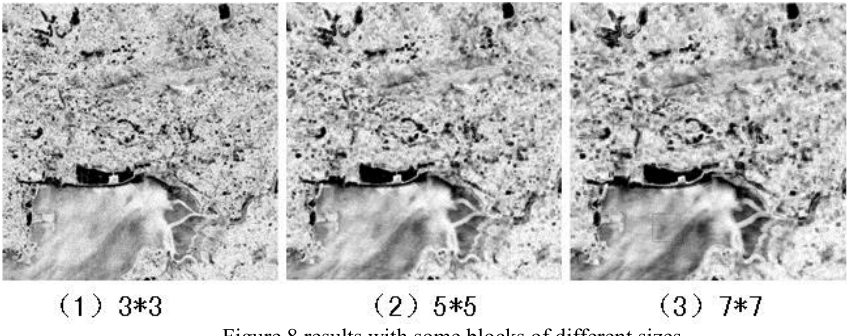
Figure 8 results with some blocks of different sizes